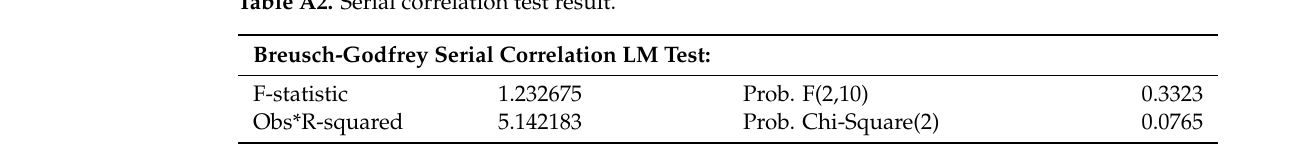
Figure A2. Model Stability test result. Table A2. Serial correlation test